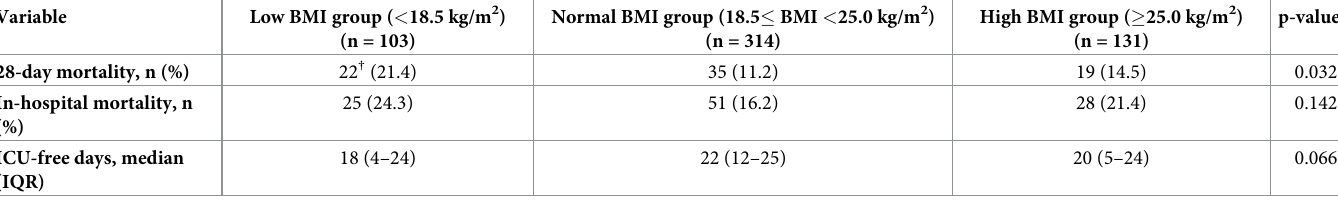
Table 3. BMI and sepsis outcomes.